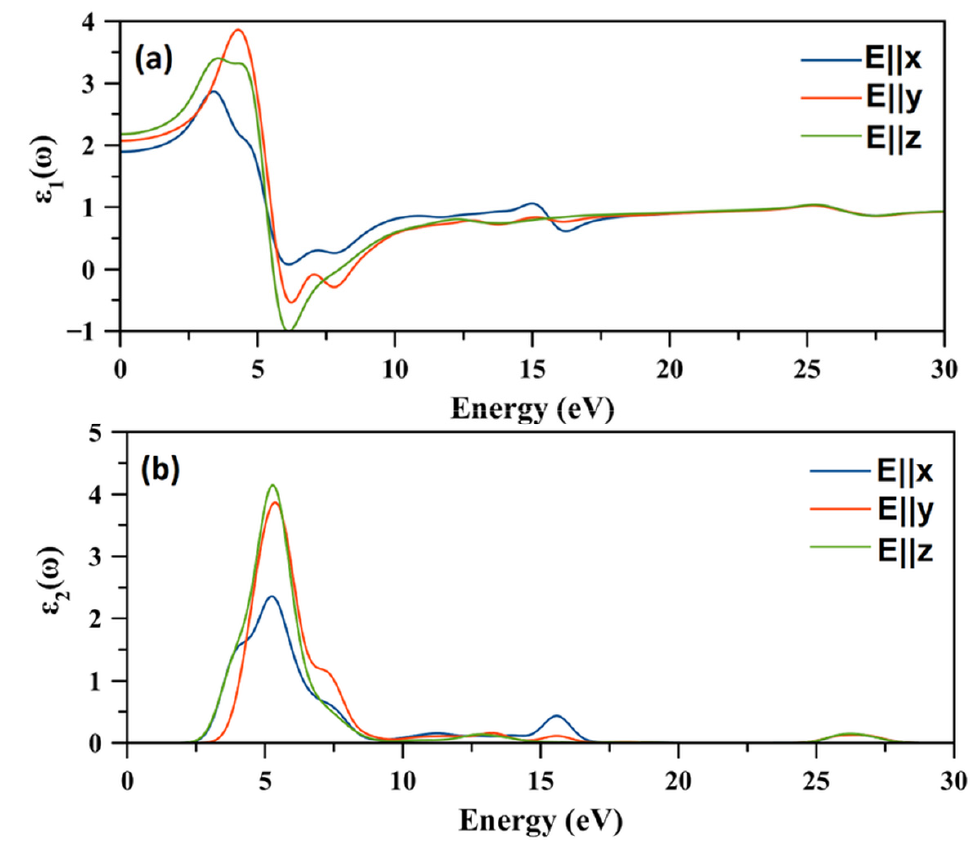
Figure 11. Variation of ( a ) the real part ε 1 ( ω ) and ( b ) the imaginary part ε 2 ( ω ) of the dielectric function as function of the energy of the (C 2 H 7 N 4 O) 2 BiCl 5 compound.